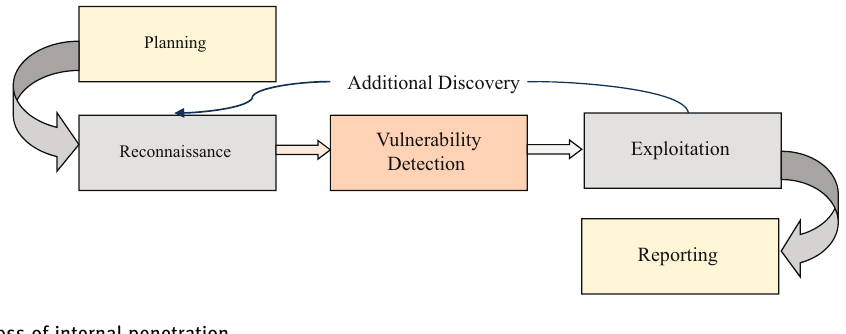
Figure 1: Process of